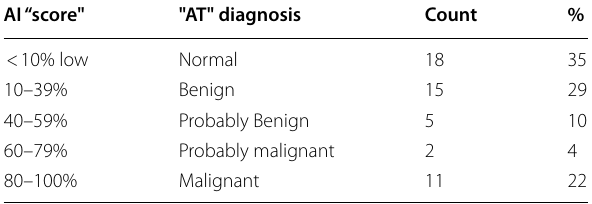
Table 5 Distribution of lesions according their AI categories AI